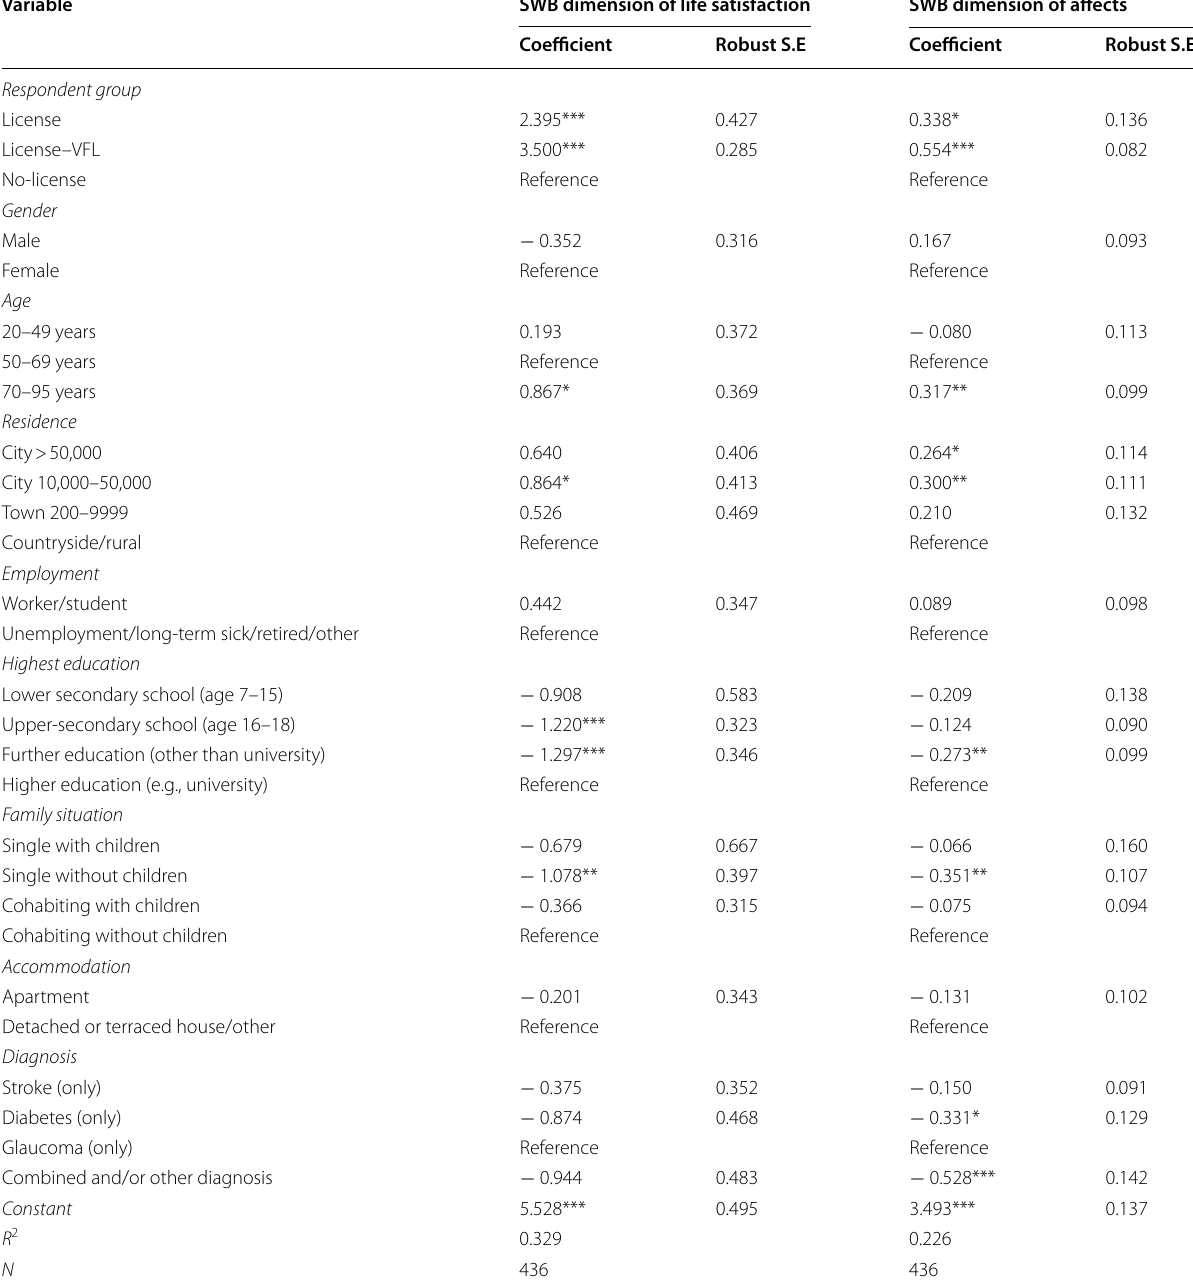
Table 2 Regression estimates regarding the two dimensions of